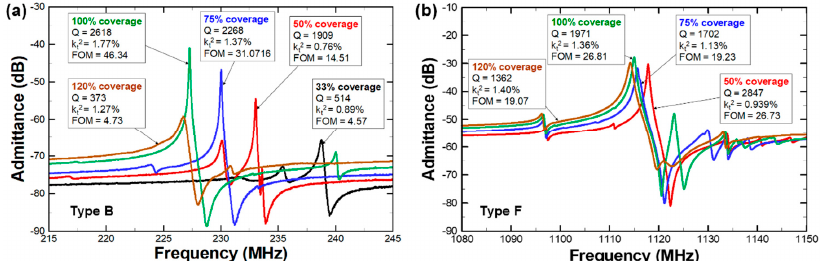
Figure 3. Admittance response of ( a ) 230 MHz and ( b ) 1.1 GHz CMRs. The changes in bottom electrode designs induce significant shift in electromechanical properties of AlN CMRs.